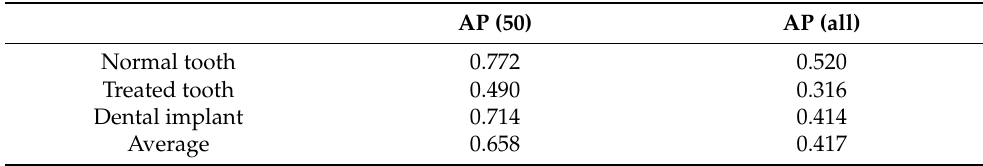
Table 3. Intersection over union (IoU) and instance-level IoU (iIoU) for each category.